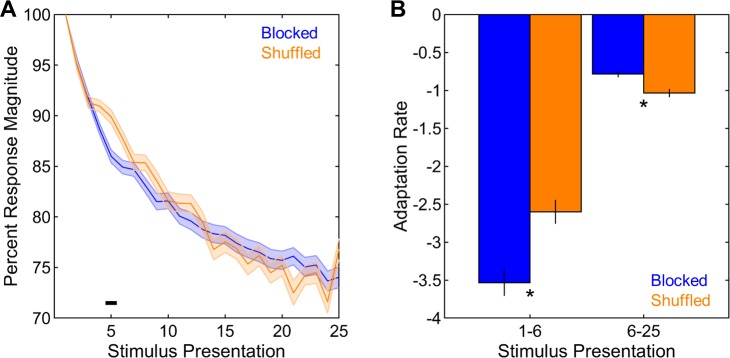
Adaptation in blocked and shuffled sequences.(A) The decrease in response magnitude (calculated as a percent of response to the first presentation) across stimulus presentations was comparable between the two sequences. (B) Adaptation rates (see Methods) in the blocked sequence were more negative for presentations 1–6 and less negative for presentations 6–25 than those in the shuffled sequence. Shadings and error bars indicate SEMs. Horizontal black bar and asterisks denote significant differences.